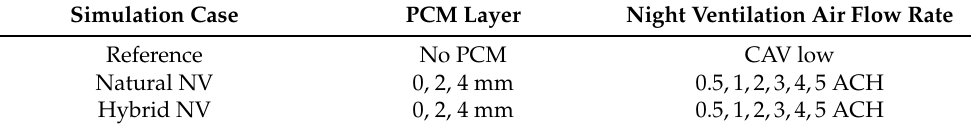
Table 7. Simulation